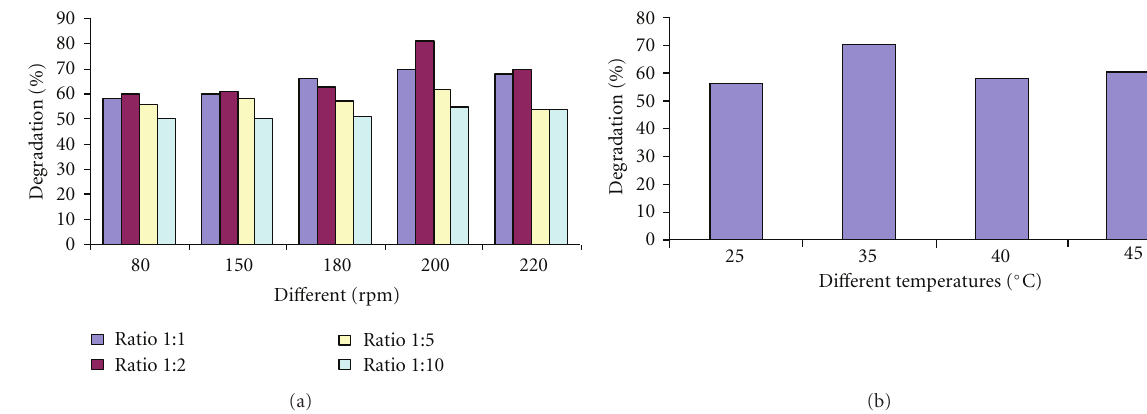
Figure 4: (a) Comparison of percentage degradation of sewage sample after 8 h at di ff erent shaking speed and by using di ff erent inoculum size of consortium 13. (b) Comparison of percentage degradation of sewage sample after 4h at di ff erent incubation temperature.